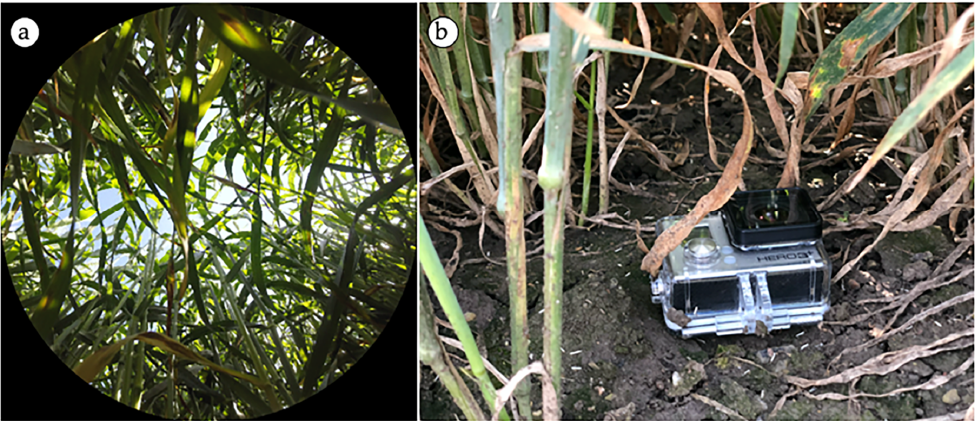
Figure 5. The device (Go Pro camera) used to take the bottom-up hemispherical images during the study ( b ) and an example of the resulting images ( a ).